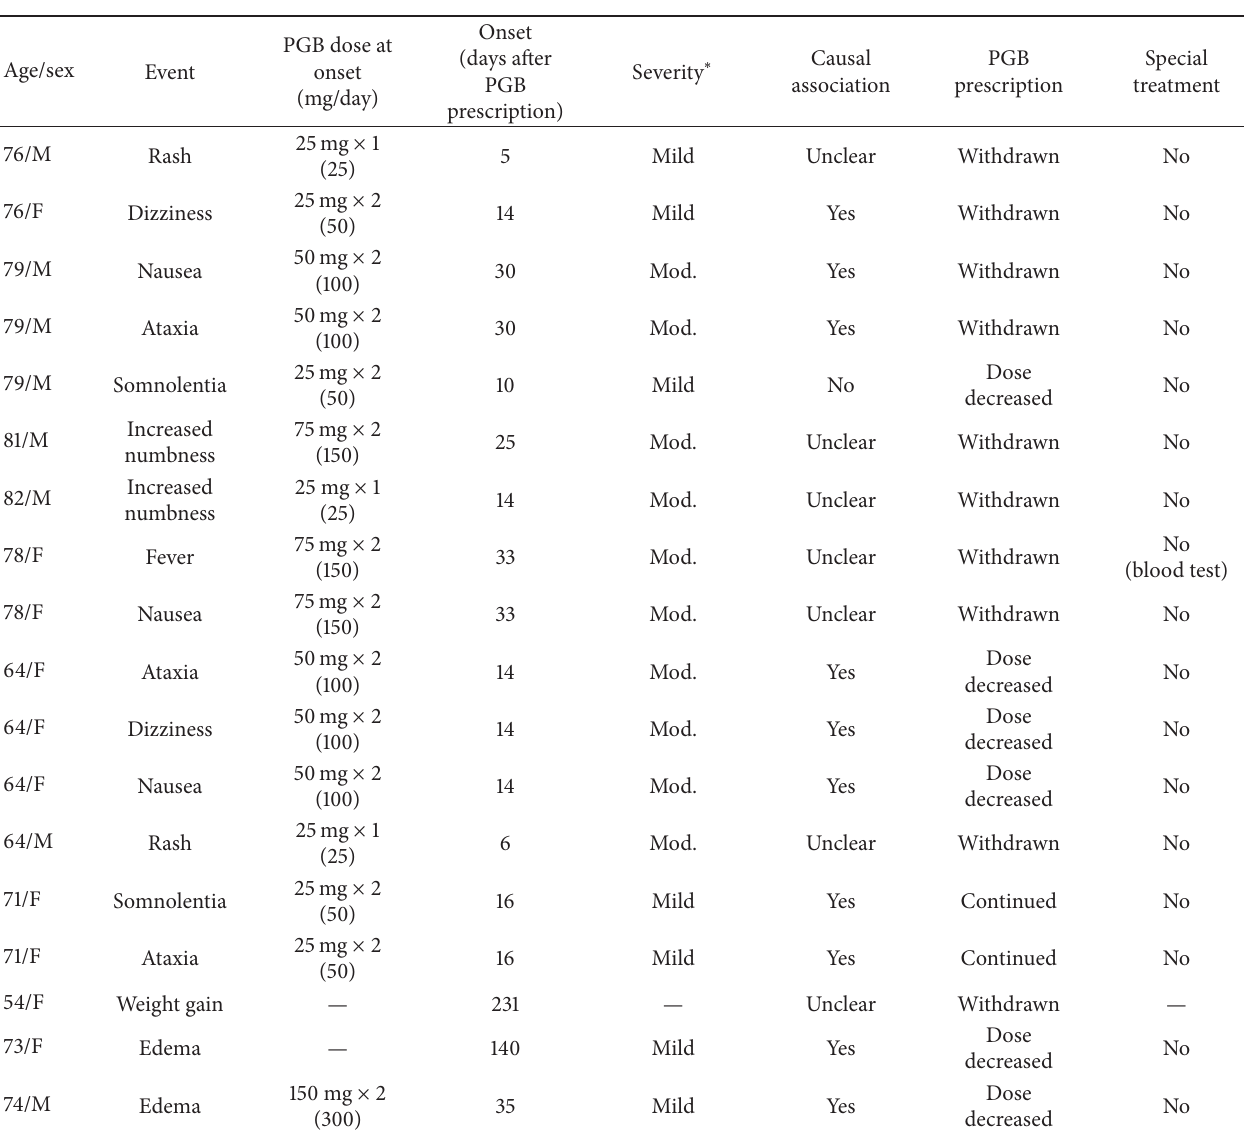
Table 3: Adverse